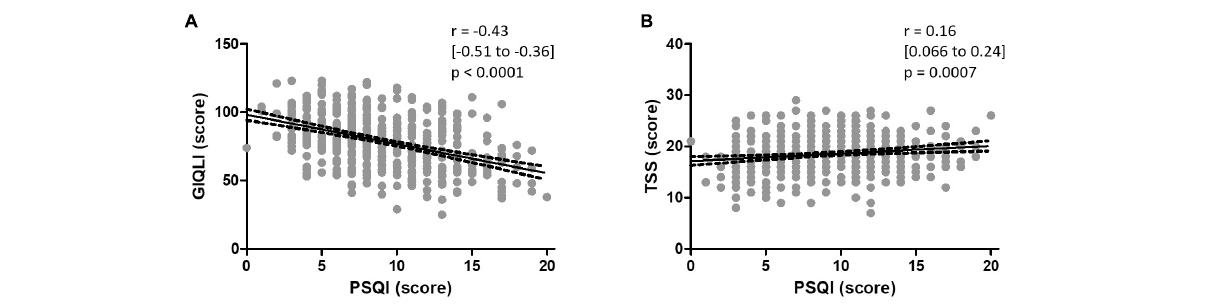
FIGURE 1 | Correlation between the global PSQI and (A) the GIQLI and (B) the TSS, with the regression line best predicting the model and its 95% confidence band in both